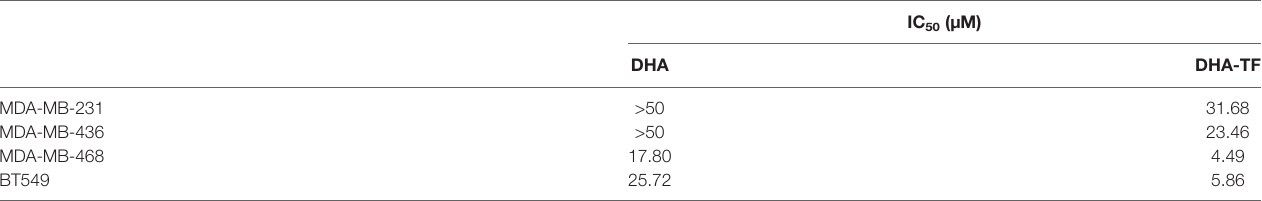
TABLE 1 | The IC 50 of DHA or DHA-TF treatment in different cell lines.